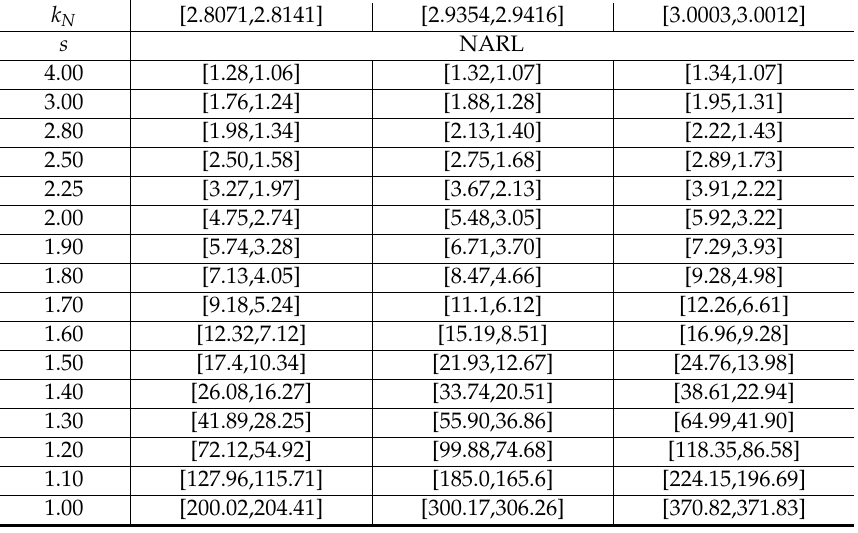
Table 1. The values of neutrosophic average run length (NARL) when a N (cid:15) [ 1.95,2.05 ] and k N (cid:15) [ 3,5 ] . k